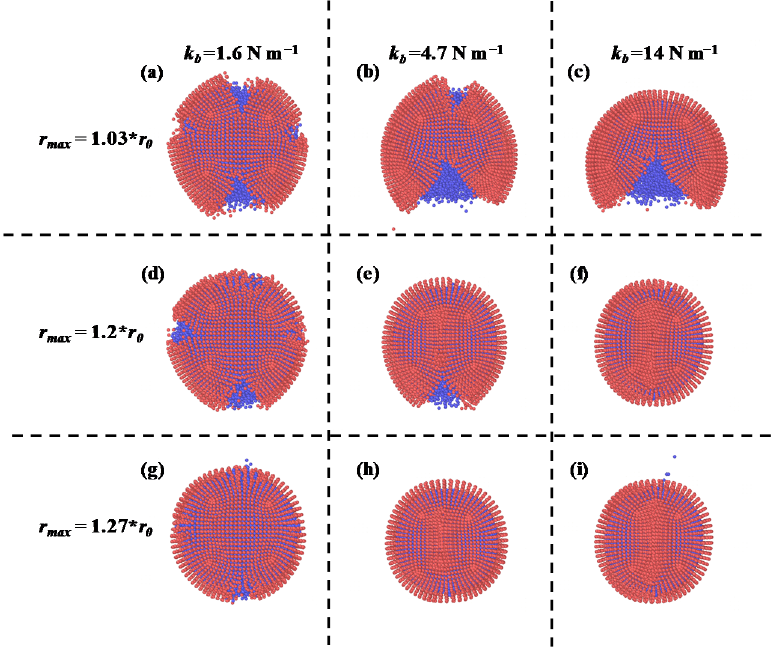
Figure 8. Capsule fractures (view from the top) at the end of each simulation for ( a ) k b =1.6 N m − 1 and r max = 1.03 * r 0 ; ( b ) k b =4.7 N m − 1 and r max = 1.03 * r 0 ; ( c ) k b = 14 N m − 1 and r max = 1.03 * r 0 ; ( d ) k b =